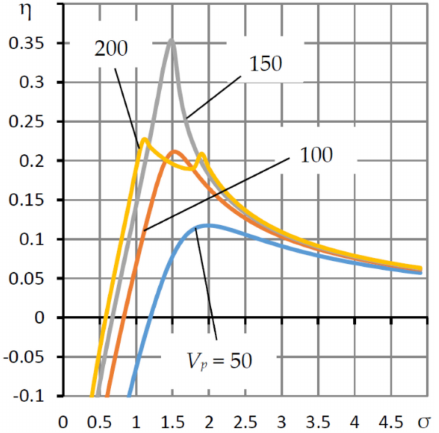
Figure 9. Dependences of the degree of stability η on the compression number σ for different values of the dimensionless volume of the inter-throttle chambers and the coefficient of elasticity K e = 2 K e 0 .